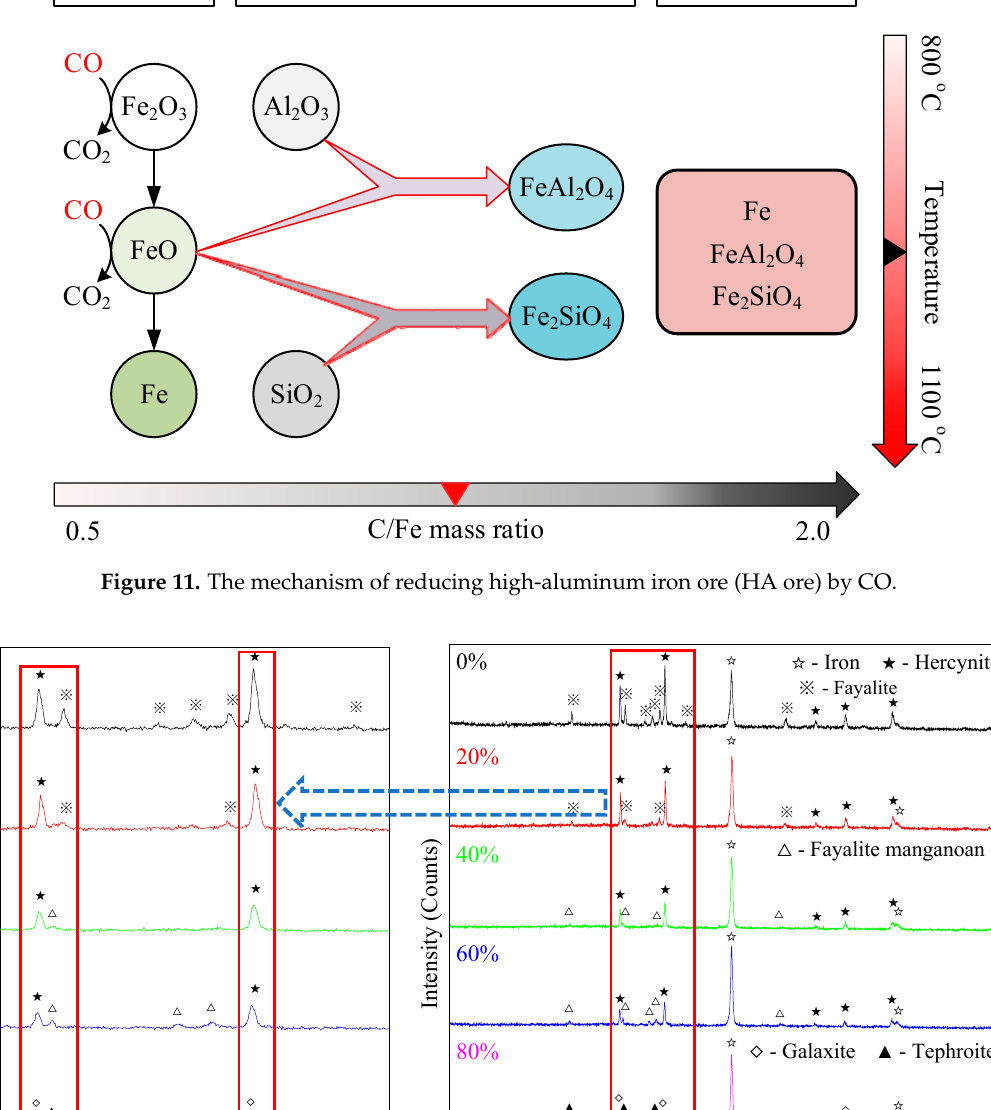
Figure 10. Thermodynamic simulation of a system consisting of Fe 2 O 3 , CO, SiO 2 , Al 2 O 3 and MnO carried out between 800 °C and 1100 °C in CO atmosphere at ambient pressure.